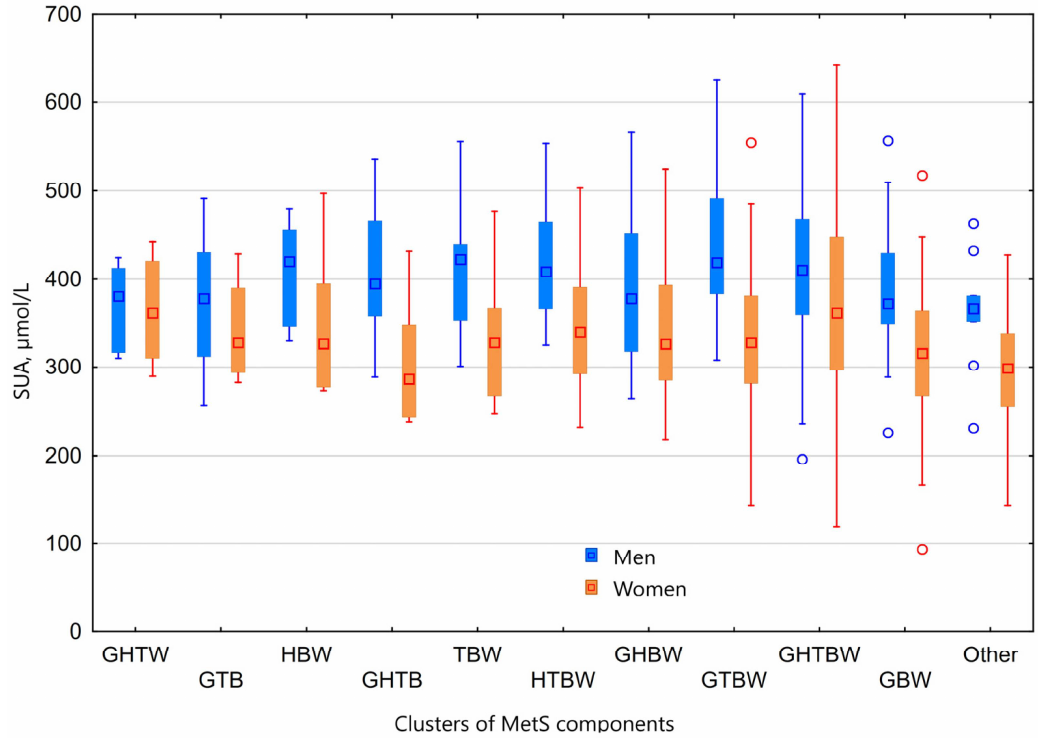
Figure 4. Clusters of MetS components and their association with SUA. SUA—serum uric acid; MetS—metabolic syndrome; G—elevated plasma glucose; H—low high density lipoprotein cholesterol; T—high triglycerides; B—elevated blood pressure; W—increased waist circumference.